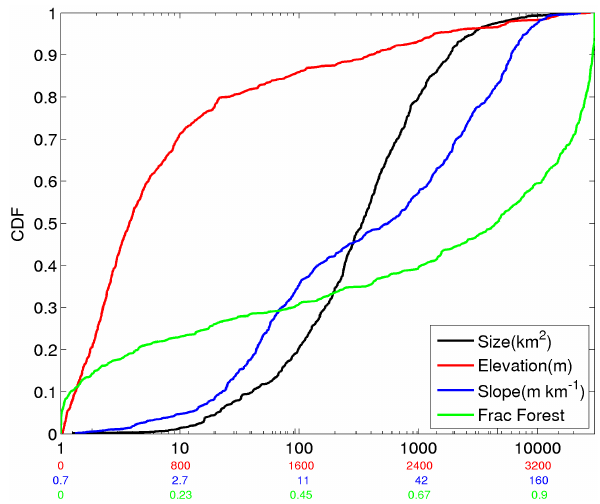
Figure 2. Annual CDFs of runoff (mmday − 1 ) (black, bottom x axis), precipitation (mmday − 1 ) (blue, bottom x axis), potential evapotranspiration (mmday − 1 ) (green, bottom x axis), and temper- ature ( ◦ C) (red, top x axis).